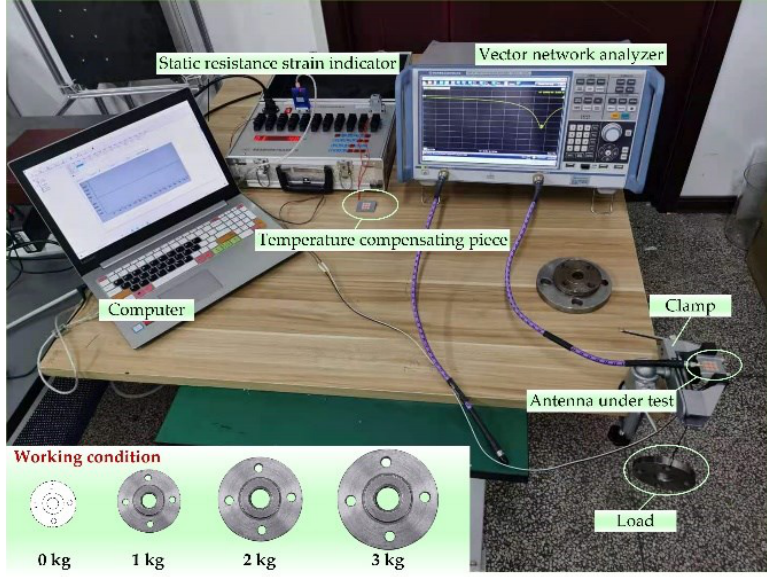
Figure 15. Measurement system.